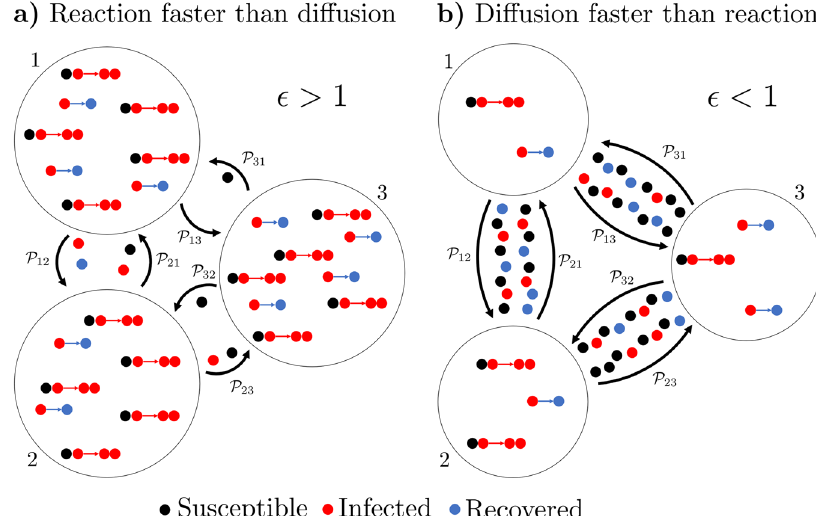
Fig. 1 Schematic illustration of reaction-diffusion processes characterized by different time scales as captured by our model. The agents are represented with dots whose colors indicate their state with respect to the disease. The big circles represent different spatial patches and the probability of going from patch j to i is represented with the black arrows and encoded in the matrix element P ij . The agents can either move around in the network, and in that case they are represented along the arrows outside the spatial patches, or stay where they are and undergo one of two epidemiological “ reactions ˮ : infection or recovery. The infections are represented with the transformations with red arrows, while for the recoveries we used blue arrows. Finally according to the time scale separation parameter ϵ we can distinguish two regimes of this model: in ( a ) ϵ > 1, so reaction events are more frequent that diffusive ones while in ( b ) ϵ < 1, so the opposite is